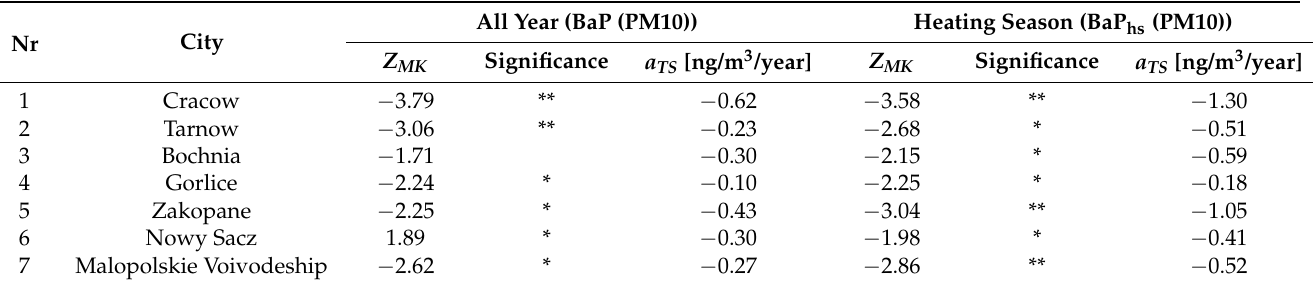
Table 4. Trends in average annual concentrations of BaP (PM10) and BaP hs (PM10) (heating